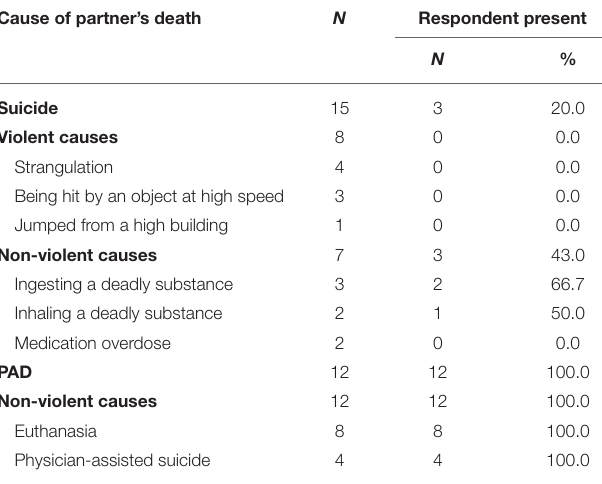
TABLE 1 | Causes of partner’s death and respondents’ presence at the death. Cause of partner’s